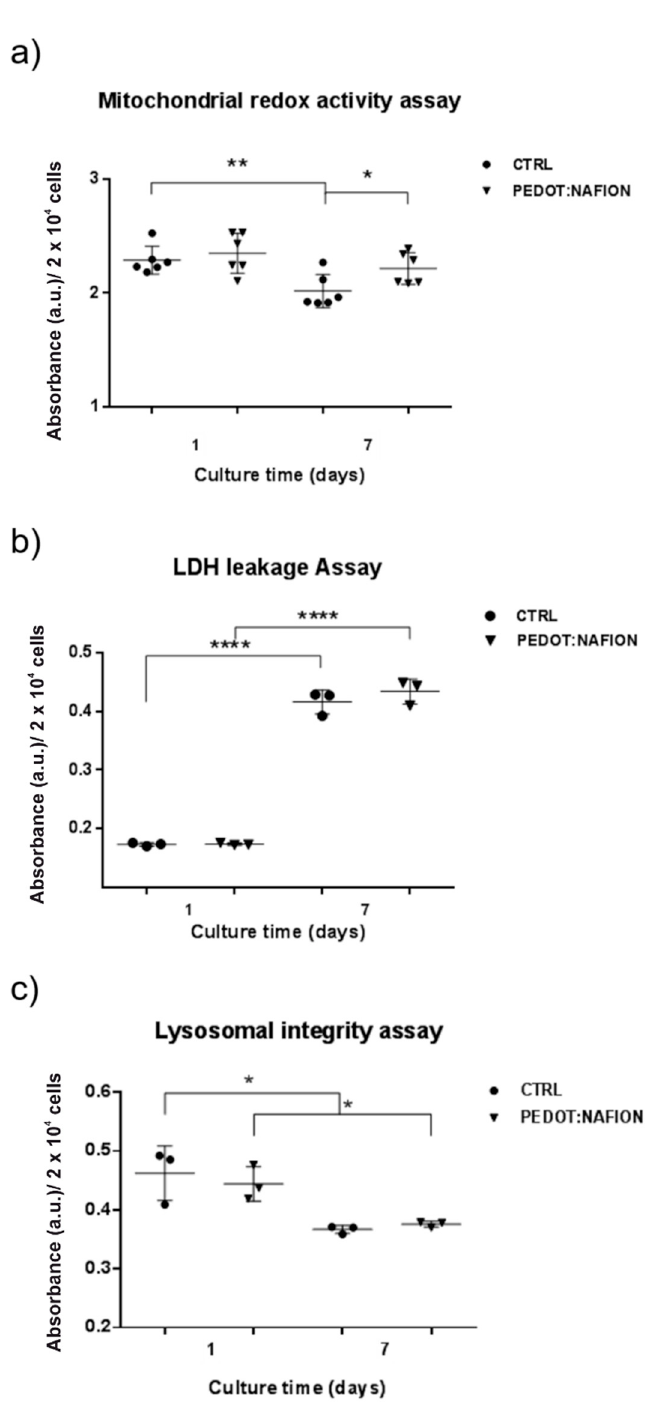
Figure 5. Evaluation of fibroblasts viability on PEDOT:Nafion coating . Cytotoxicity of the PEDOT:Nafion coating was evaluated by MTT ( a ), LDH ( b ) and neutral red assay ( c ) at 1 day and 7 days after seeding (* p < 0.05, ** p < 0.01, **** p < 0.0001).